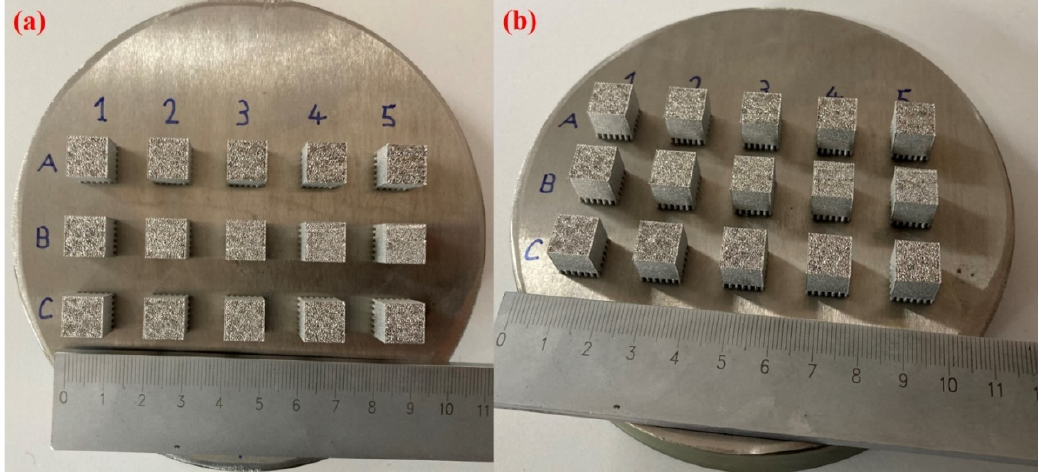
Figure 7. Fifteen samples printed using cylindrical supports by laser powder bed fusion process ( a ) top view and ( b ) inclined view.